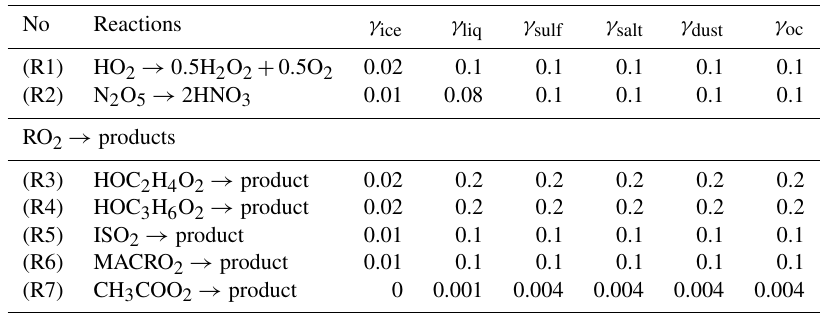
Table 2. Heterogeneous reactions in